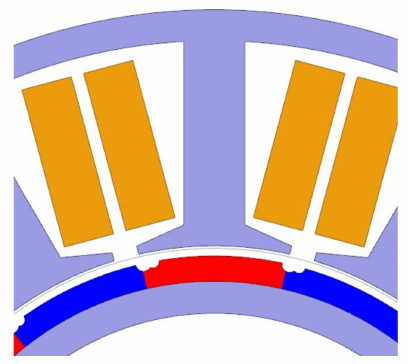
Figure 12. Schematic diagram of the final slotting result.